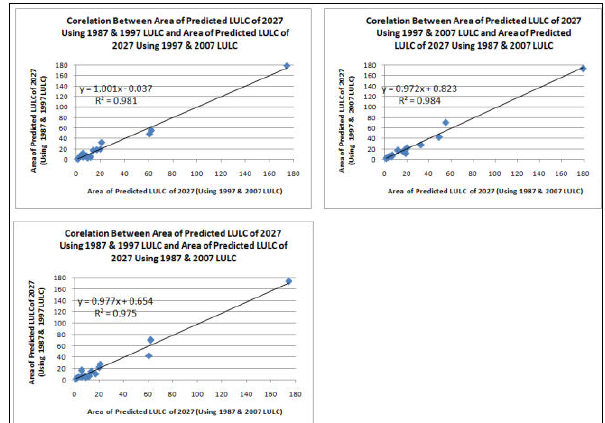
Figure 4. Relationships between area statistics of predicted using 1997 & 2007 LULC images and using 1987 & 2007 LULC of 2017 using 1987 & 1997 LULC image, area statistics LULC images. of predicted LULC of 2017 using 1997 & 2007 LULC image and area statistics of predicted LULC of 2017 using 1987 & 2007 LULC image